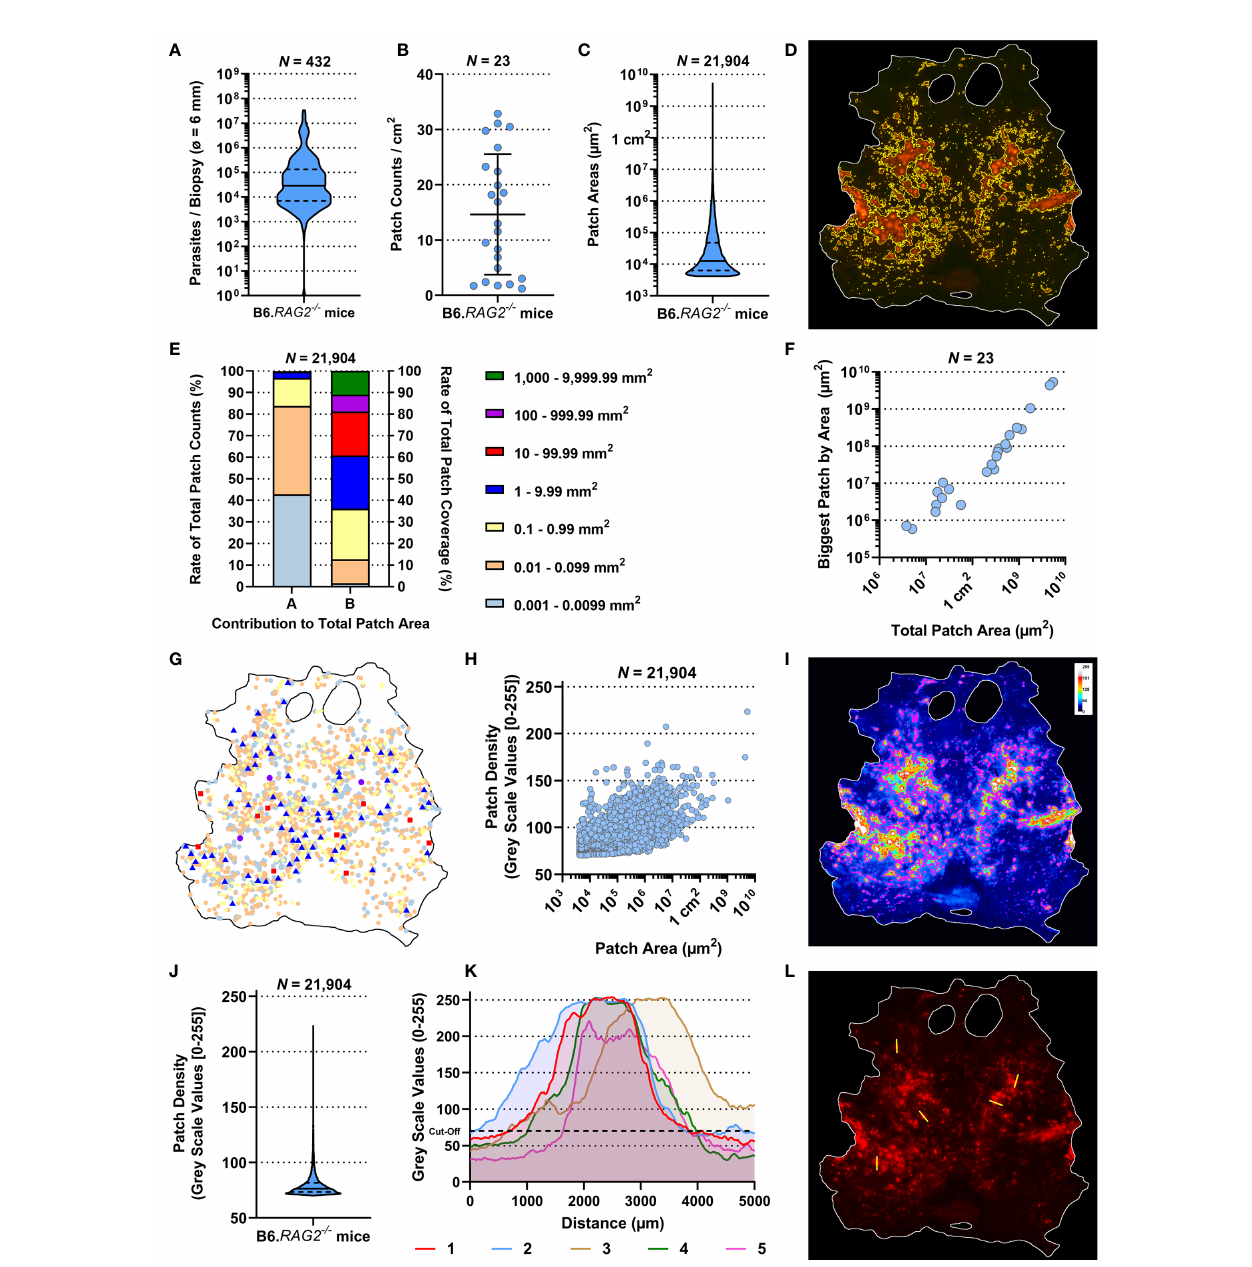
FIGURE 2 | Observational description of the skin parasite landscape. All data presented here were generated by the ImageJ-based analysis of stereomicroscopic images. (A) Accumulative qPCR data of estimated parasite loads/biopsy from 432 biopsies (ø 0.6 cm) of 23 RAG mice. (B) Average patch counts/cm 2 of skin for 23 RAG mice. (I, K) Comparison of ratios of parasitized skin by body region for 23 RAG mice (Friedman Test: p = 0.3113 and p = 0.2931, respectively). (C) Accumulative data of the individual area of 21,904 measured patches from 23 RAG mice. (D) Representative image of detected patches in the RAG4 mouse skin. (E) Arranged data from 21,904 individually detected patches from 23 RAG mice arranged by “ A ” , the ratio of patch counts/size category, and by “ B ” , the contribution of size category to the overall patched area in the skin. (F) Correlation plot of total parasite patched skin by area (µm 2 ) against the size of the biggest parasite patch detected in each of the 23 RAG mice (both on a log-scale; Spearman r : p < 0.0001, r = 0.9792, 95% CI = 0.9496 – 0.9915). (G) Schematic distribution of patches over the skin of RAG4 marked by patch area according to the categories in (E) . (H) Correlation plot of 21,904 skin parasite patches by area (µm 2 ) from 23 RAG mice (on a log-scale) against their respective mean pixel density on an 8-bit grayscale (Spearman r : p < 0.0001, r = 0.6554, 95% CI = 0.6476 – 0.6631). (I) Representative 8-bit grayscale image showing the tdTomato light intensity per pixel (RAG4). In magenta are the outlines of detected skin patches. (J) Accumulative data of mean patch density/patch of 21,904 individually detected patches from 23 RAG mice. (K) X – Y plots of fi ve 5-mm cross sections through patches measuring tdTomato signal intensity/pixel on grayscale [0 – 255] in the RAG4 skin image. The arbitrary cutoff for patch detection set at 70 is marked in these graphs with black dashed line. (L) Image of the RAG4 image indicating where cross sections through patches were